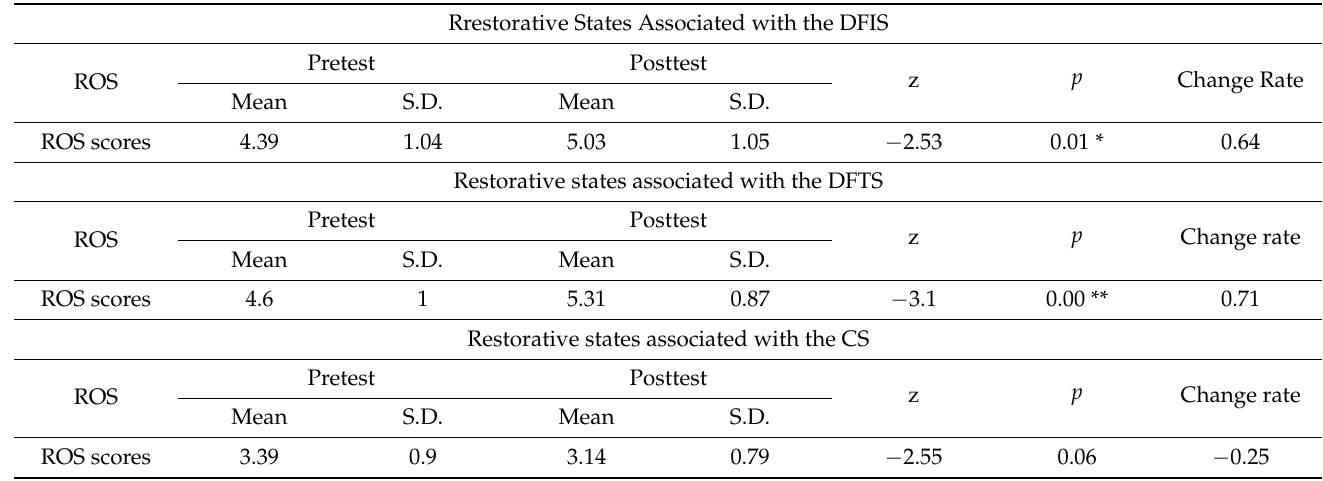
Table 3. Effects of the three stimulating environments on restorative states .